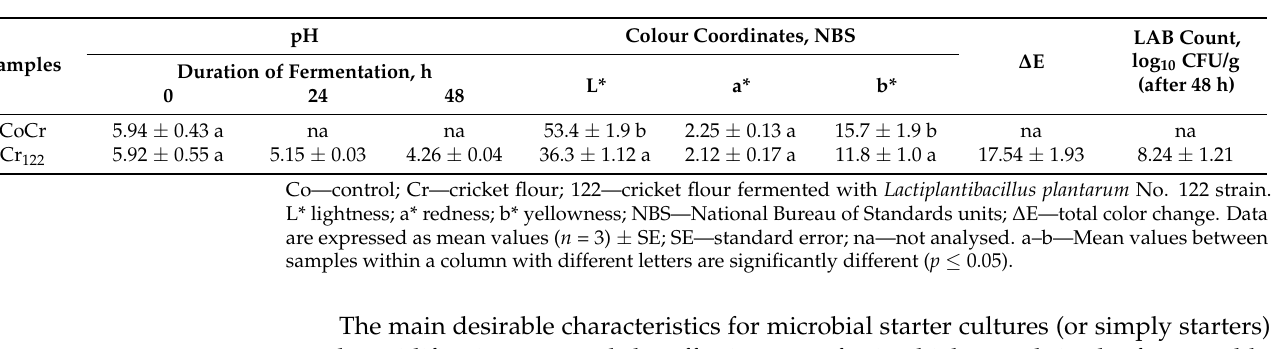
Table 2. pH, color coordinates, total color change ( ∆ E), and lactic acid bacteria (LAB) viable counts in non-treated and fermented cricket